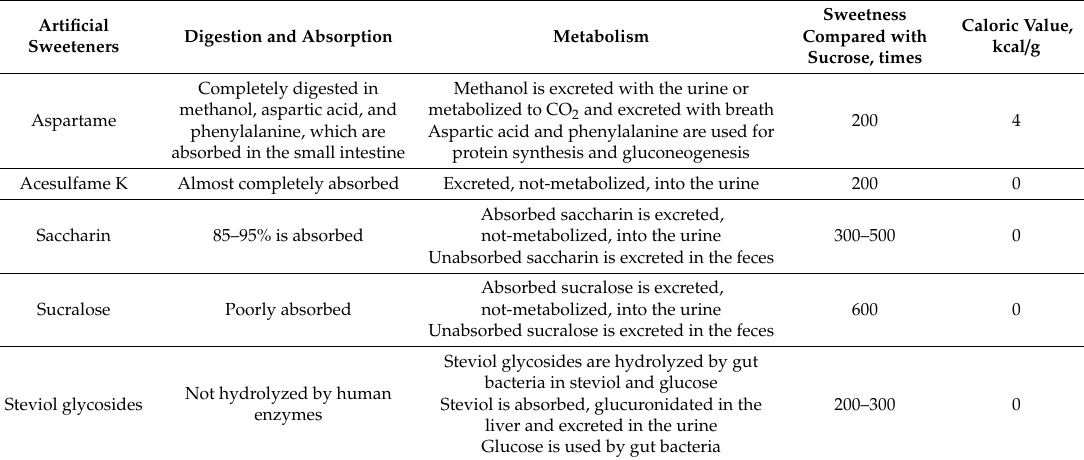
Table 3. Characteristics and properties of the most used artificial